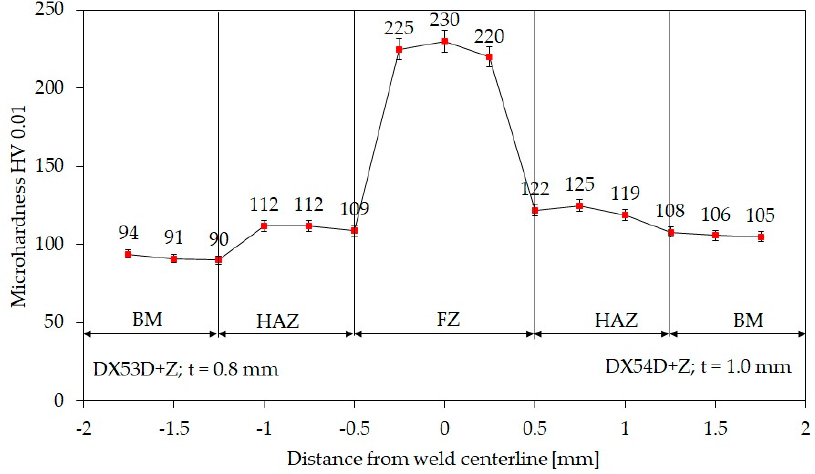
Figure 6. Microhardness distribution of TWB1.